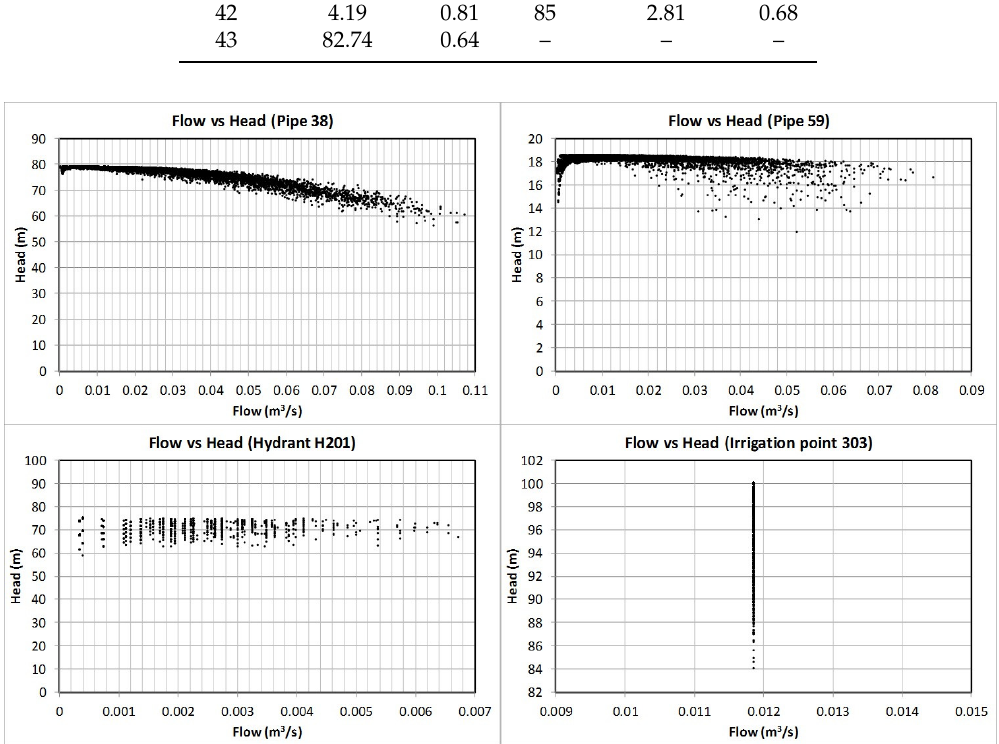
Figure 20. Representation of flow versus head for ideal turbine characteristics in irrigation point, hydrant and lines 38 and 55.